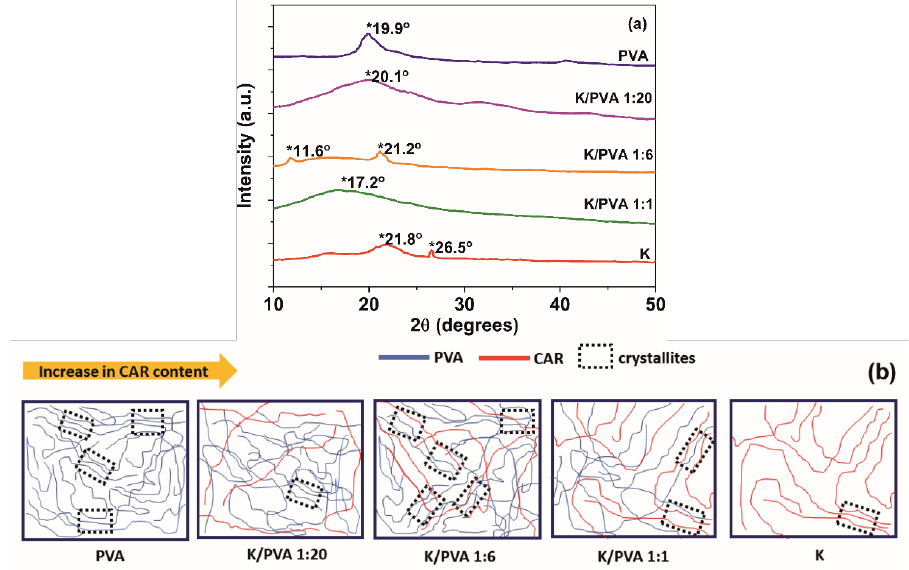
Figure 2. ( a ): XRD di ff ractograms of the obtained hydrogels; ( b ): a tentative mechanism for hydrogels cryostructuring.